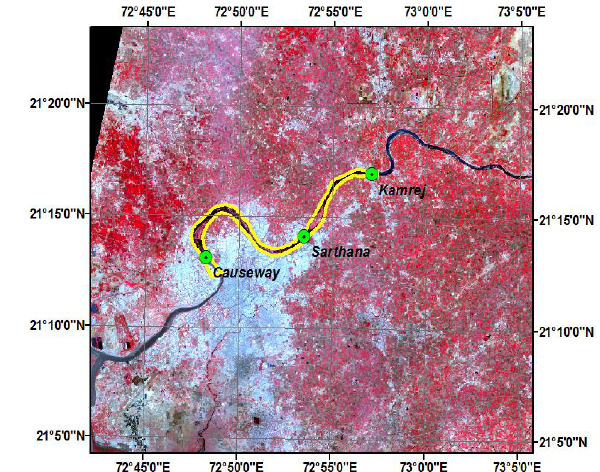
Figure 2. Study area Tapi River, green color marker shows the sampling locations and yellow color shape file highlights the extent of the river for the analysis